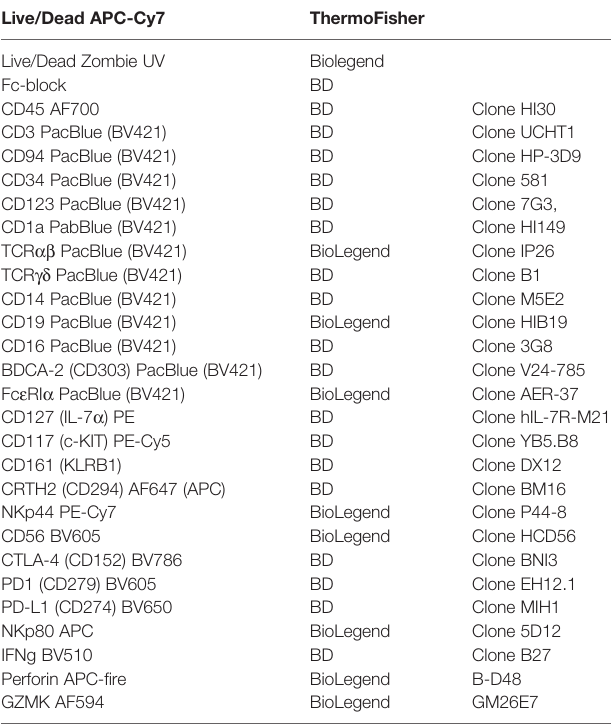
TABLE 1 | Antibodies for fl ow